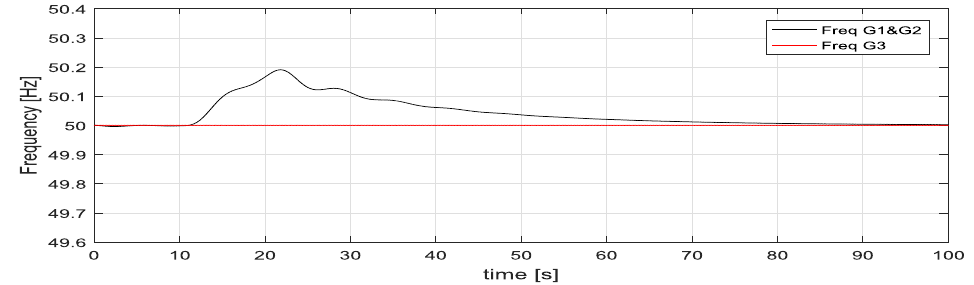
Figure 15. Time evolution of frequency on the busbar at 33